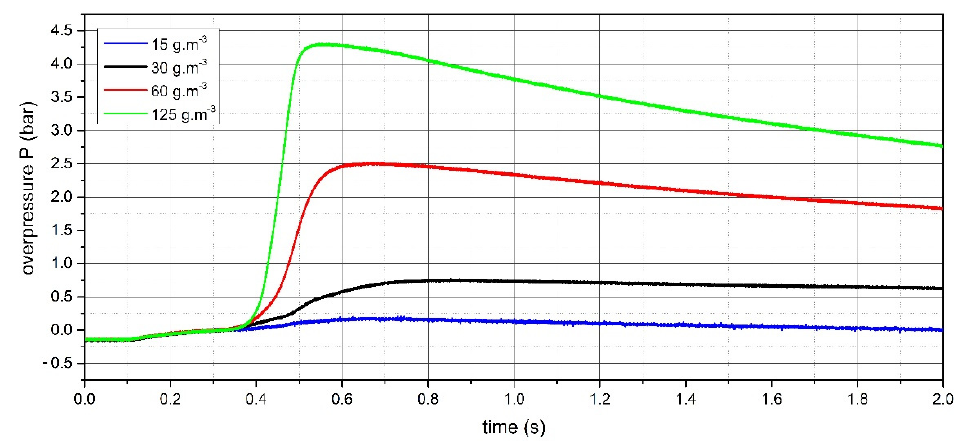
Figure 9. Pressure record of PA12 polyamide explosion at concentration 750 g·m -3 .